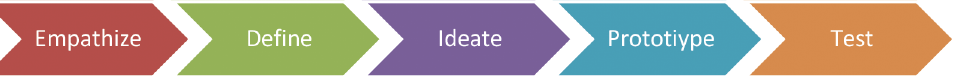
Figure 1. Stages of Design